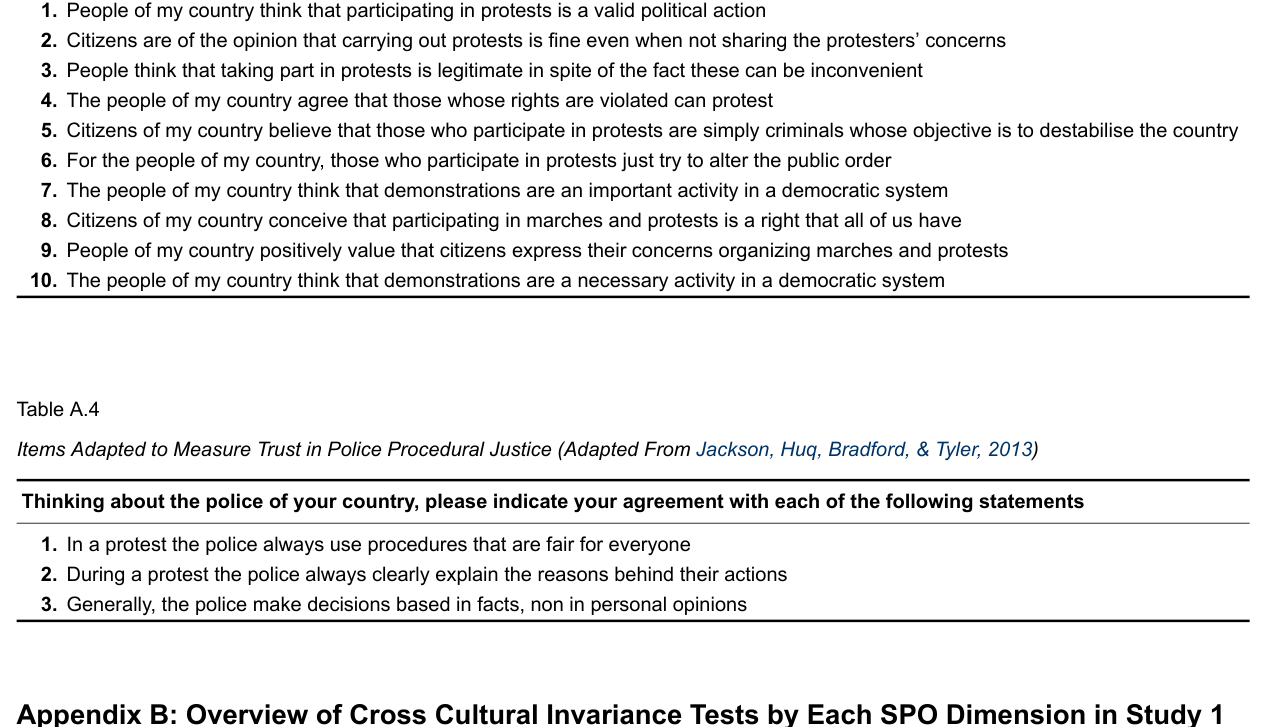
Goodness-of-fit Indices and Comparison of Models Testing Measurement Invariance for Government Openness